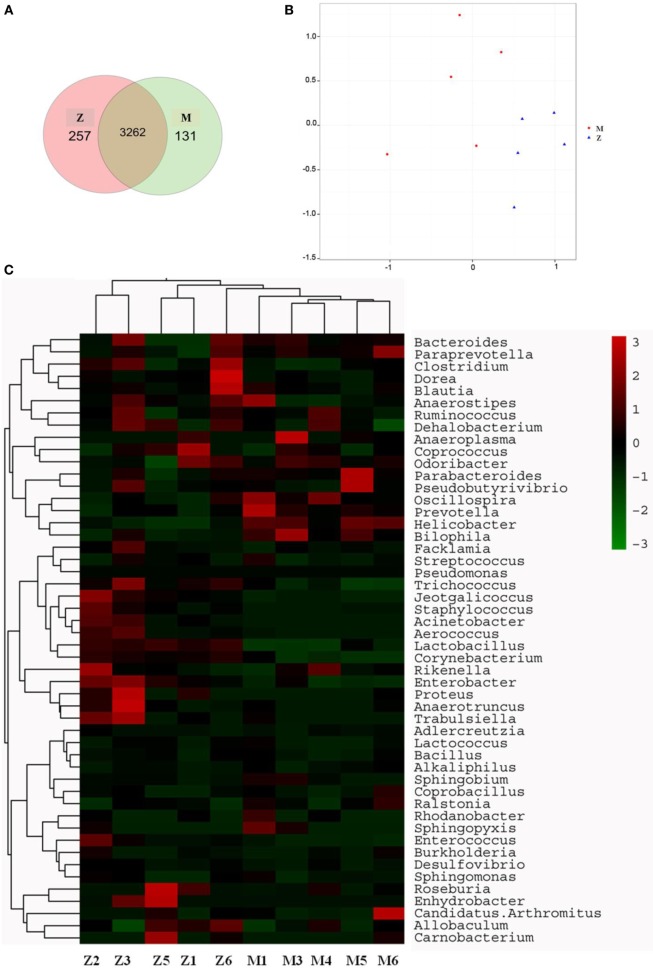
Influence of cyclophosphamide on the cecal microbiota of mice. (A) The Venn diagram; (B) the PCA analysis of operational taxonomic units; (C) heat map of 16S rRNA gene sequencing analysis of cecal content at the genus level. Z denotes the control (normal) group just treated with vehicle, and M is the cyclophosphamide-induced (intraperitoneal injection of 80 mg/kg) group.